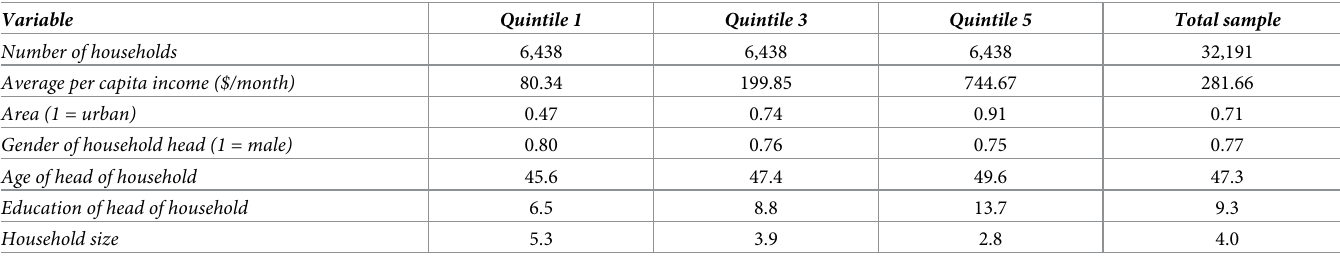
Table 1. Sociodemographic descriptive statistics: Whole sample and income quintiles.